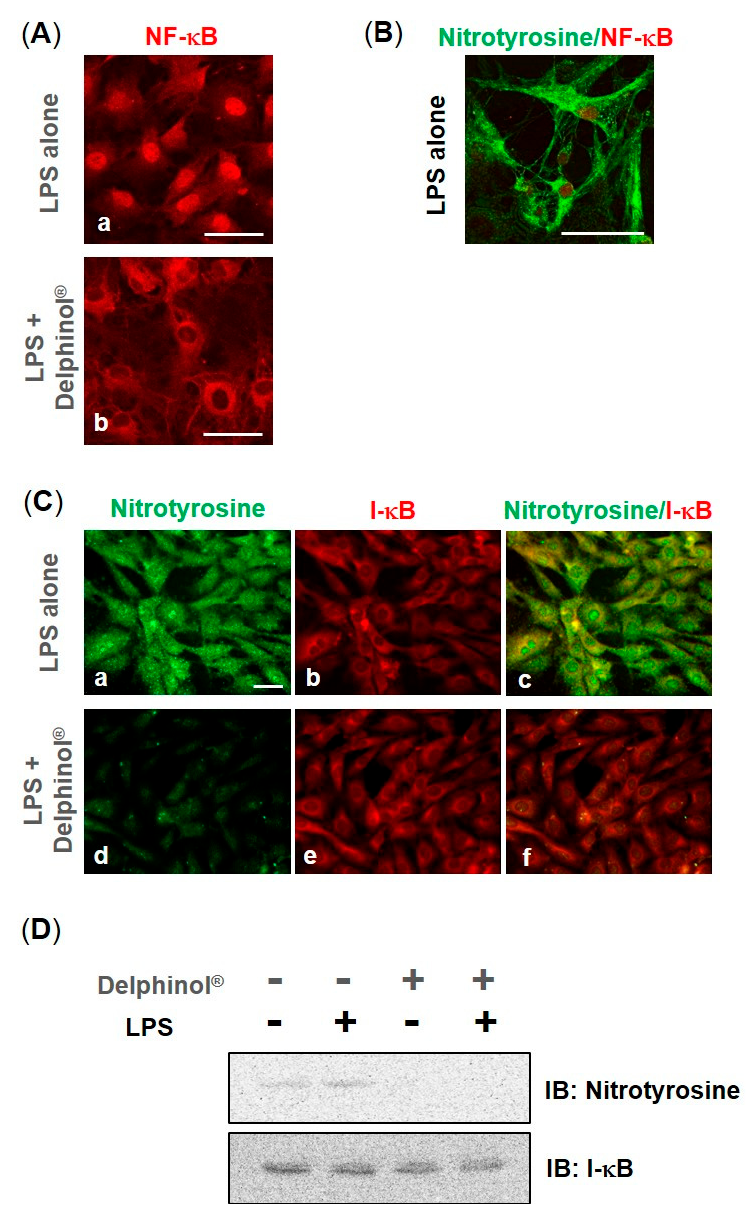
Figure 2. Effects of Delphinol ® on the transnucleation of NF- κ B and tyrosine nitration of I- κ B. (A–C ) Immunofluorescent staining of MC3T3-E1 cells for NF- κ B/p65, nitrotyrosine, and I- κ B. Cells were grown for 3 days in the absence or presence of 25.0 μ g/mL Delphinol ® , then incubated with 10 μ g/mL LPS for 3 h. Scale bars = 50 μ m. ( D ) Cell samples were immunoprecipitated with anti I- κ B antibody, and then blotted with either anti-nitrotyrosine antibody or anti-I- κ B antibody.